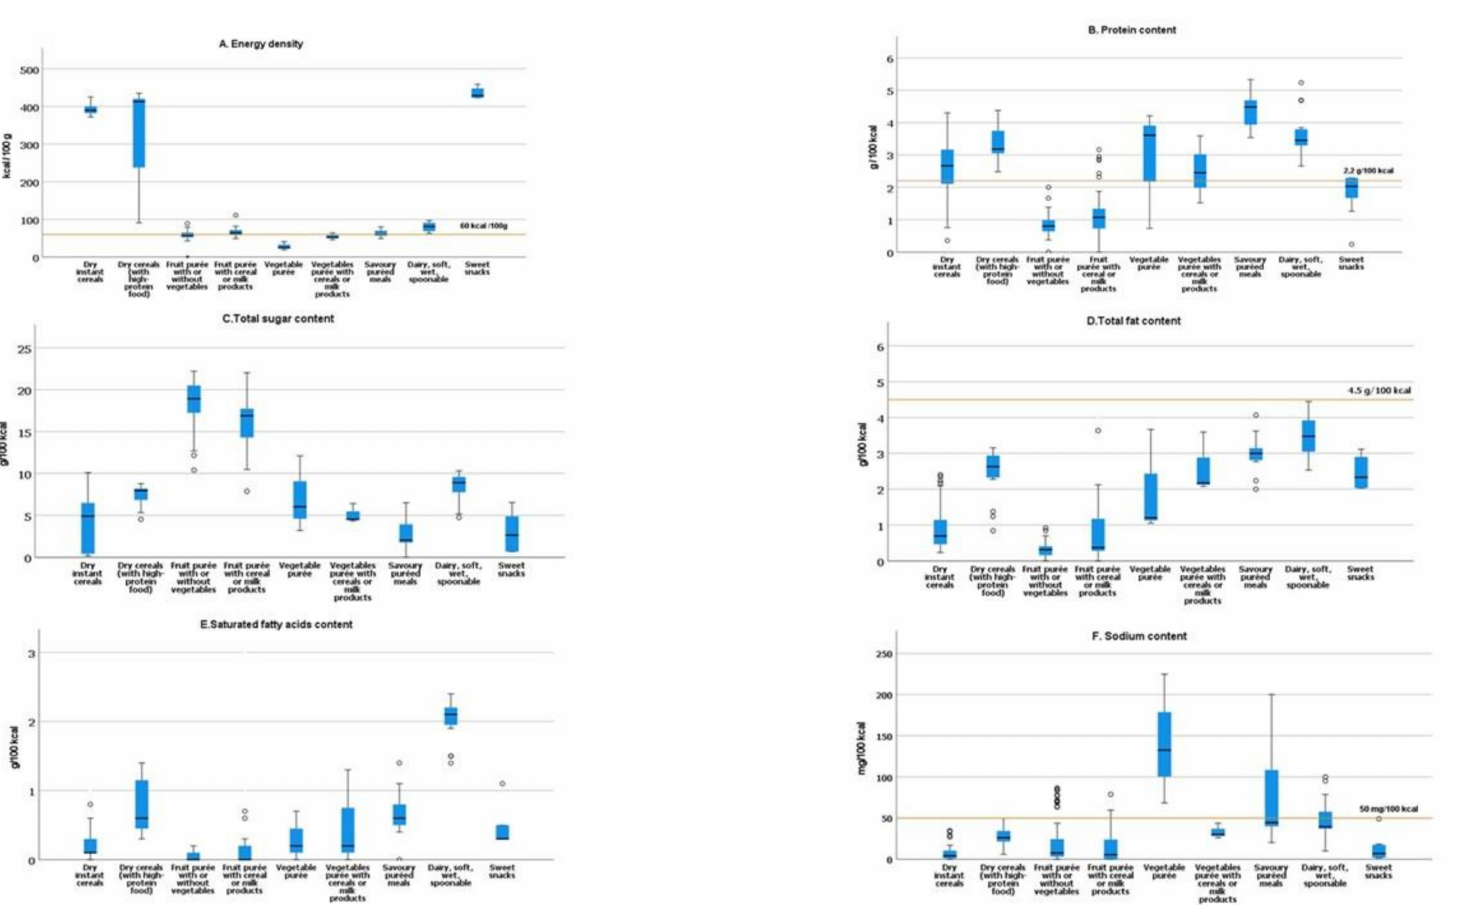
Figure 2. ( A ) Energy density of food products. The horizontal yellow line at 60 kcal/100 g indicates the minimum energy density adopted by the NPM of the WHO/Europe for several CACFs categories. ( B ) Protein content of food products. The line at 2.2 g/100 kcal indicates a lower limit adopted by the NPM of the WHO/Europe for several CACFs categories. ( C ) Total sugar content of food products; ( D ) total fat content of food products; ( E ) saturated fatty acids content of food products. The yellow line at 4.5 g/100 kcal indicates an upper limit for total fat adopted by the NPM of the WHO/Europe for some CACFs categories; ( F ) sodium content of food products. The yellow line at 50 mg/100 kcal indicates the upper limit for sodium adopted by the NPM of the WHO/Europe for some CACFs